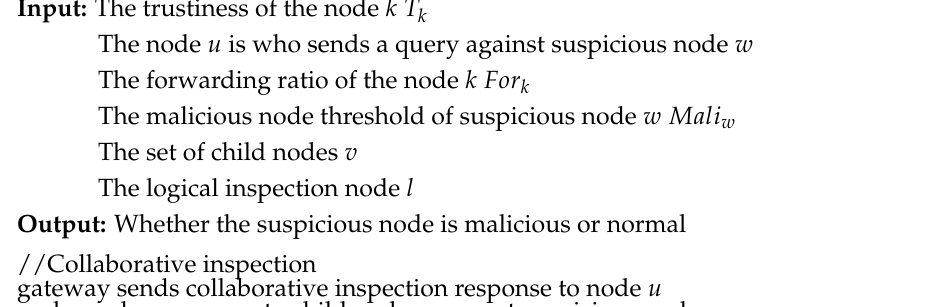
Algorithm 3 Algorithm for Gateway-independent and Gateway-assisted Trust